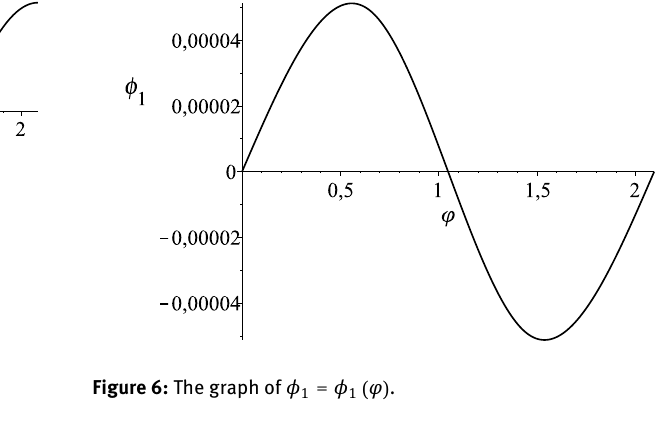
With arbitrary ϕ = 1, 2; p = 1, 2, . . . ) the cross- 1 p ( i sectional rotations given by Eq. (60) satisfy the geometric boundary conditions formulated in Eq. (57). Substitution